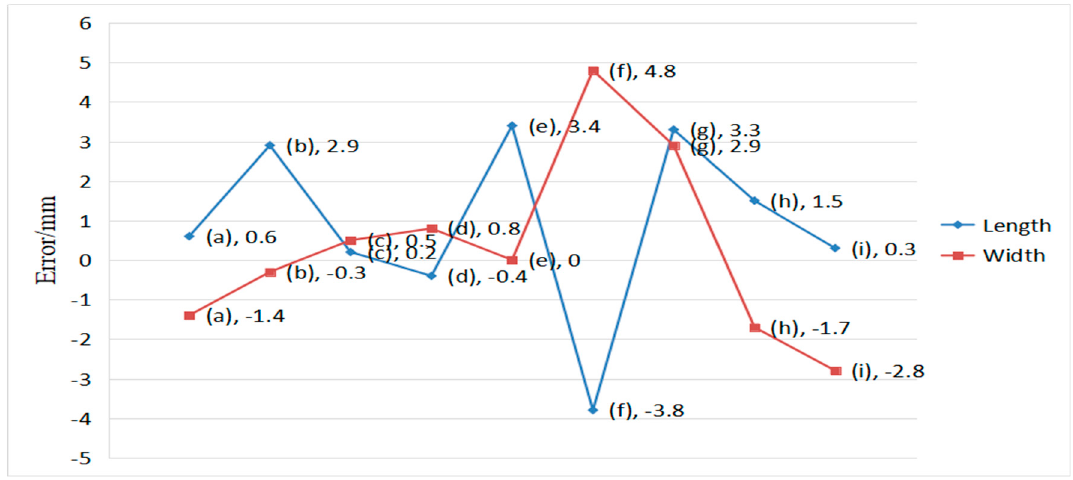
Figure 19. Errors between the standard box and the measured result.